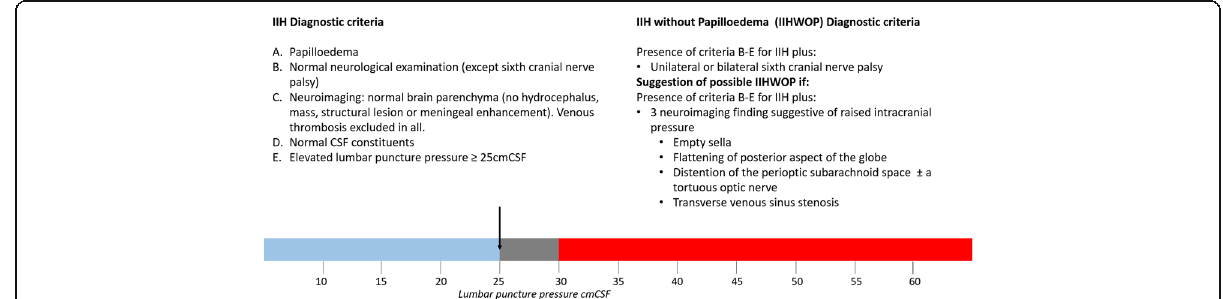
Fig. 1 Diagnostic criteria for IIH (Friedman criteria). Diagnostic criteria for IIH and IIH without papilloedema. Infogram demonstrating the “ grey zone ” in which LP pressure is normal in some individuals but can indicate pathologically raised ICP in some. Measurements in the grey zone need to be interpreted with caution and patients must fit the other criteria for IIH for a diagnosis to be confirmed